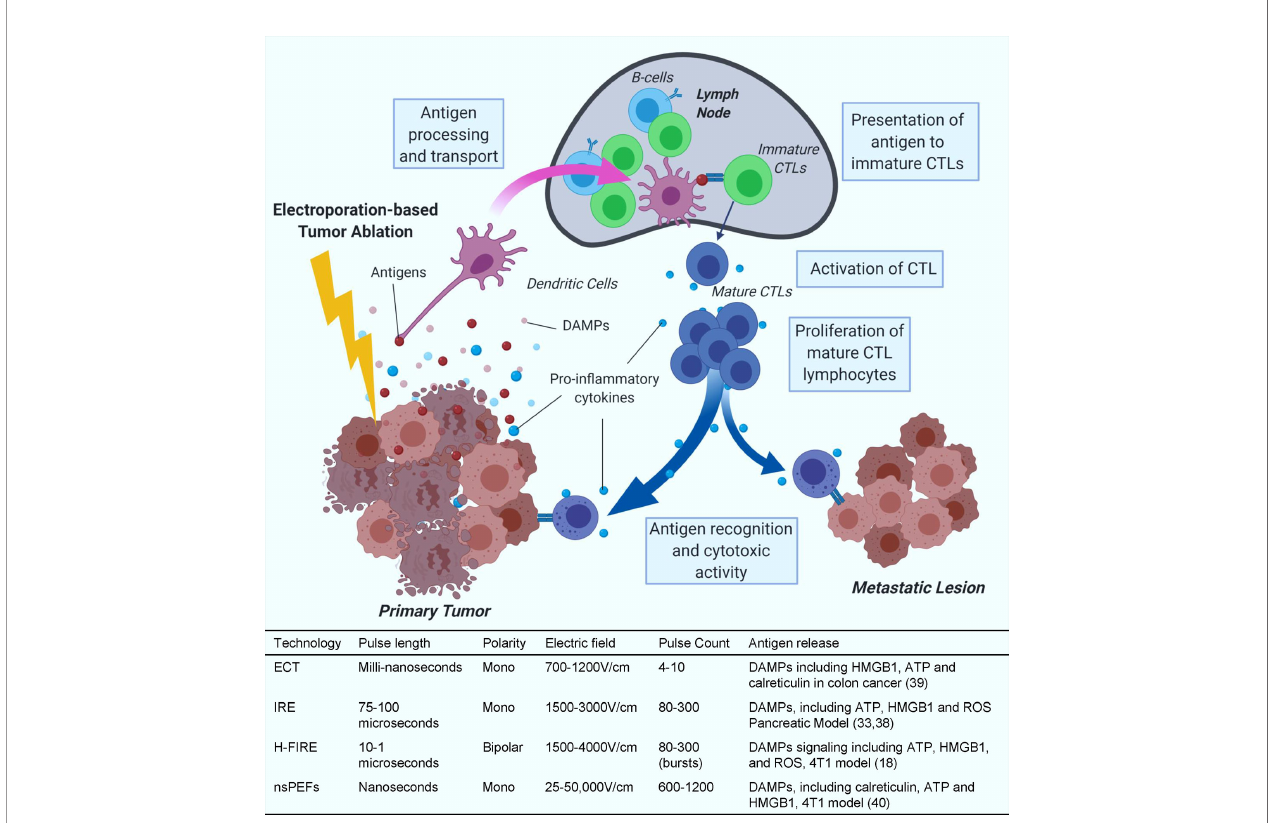
FIGURE 1 | Antigen release and presentation. Collection and presentation of antigens by dendritic cells to cytotoxic T-cells (CTLs) and subsequent CTL activity after IRE treatment. Treatment parameter value ranges are based on commonly reported parameters in literature for in vivo preclinical and clinical applications. These ranges are not de fi nite and applications outside of these ranges can